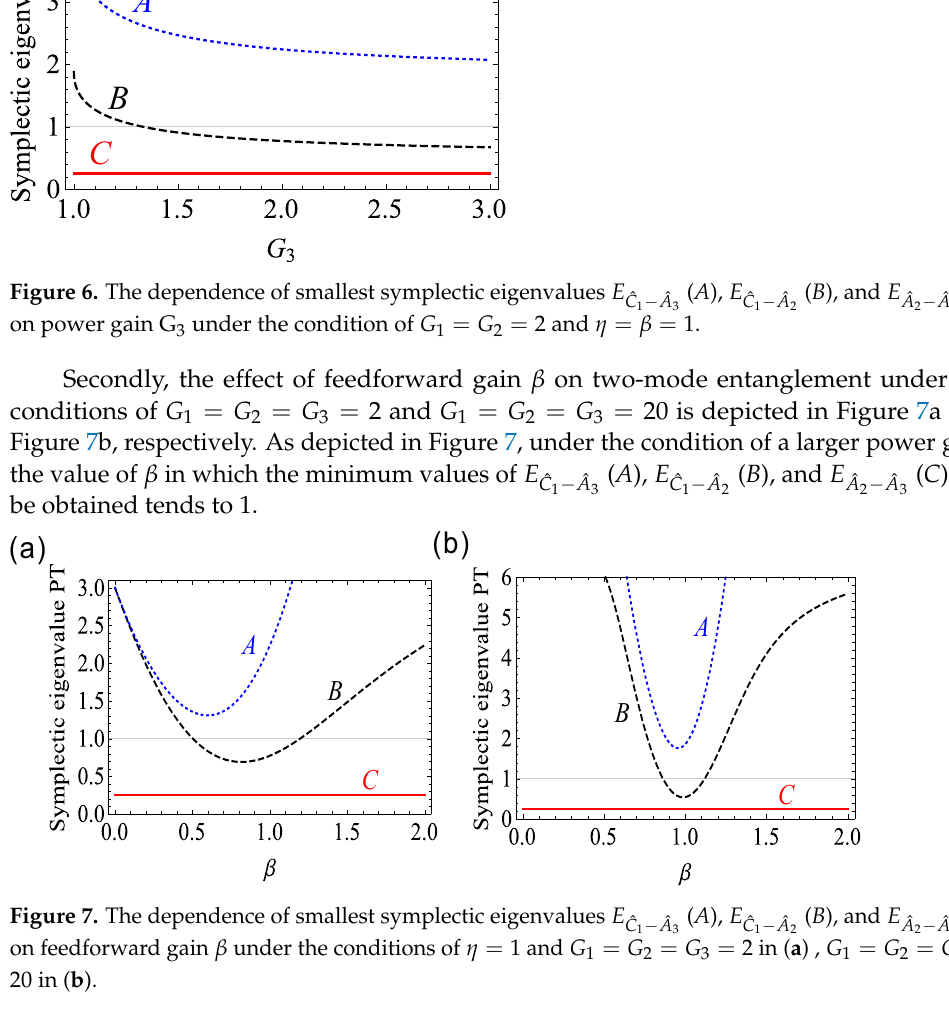
( A ), E ˆ ( B ), and E ˆ ( C ) C 1 − ˆ A 3 C 1 − ˆ A 2 A 2 − ˆ A 3